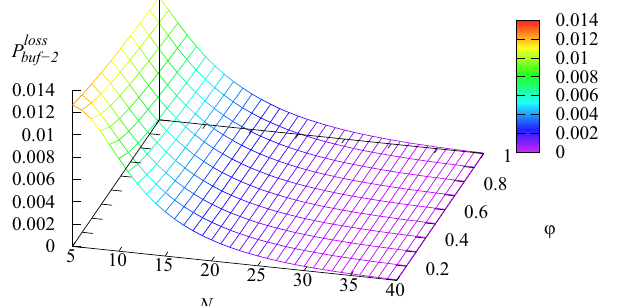
Figure 7. Dependence of the loss probability P loss ϕ and N